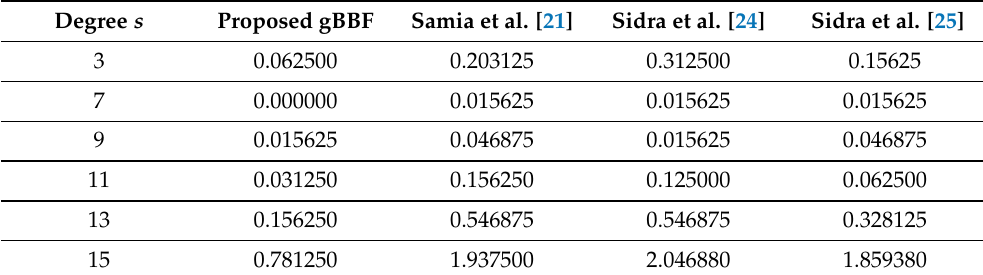
Table 2. Computational comparisons of gBBF between existing Bernstein-like basis functions in terms of CPU time (s). Degree s Proposed gBBF Samia et al. [21] Sidra et al. [24] Sidra et al. [25]